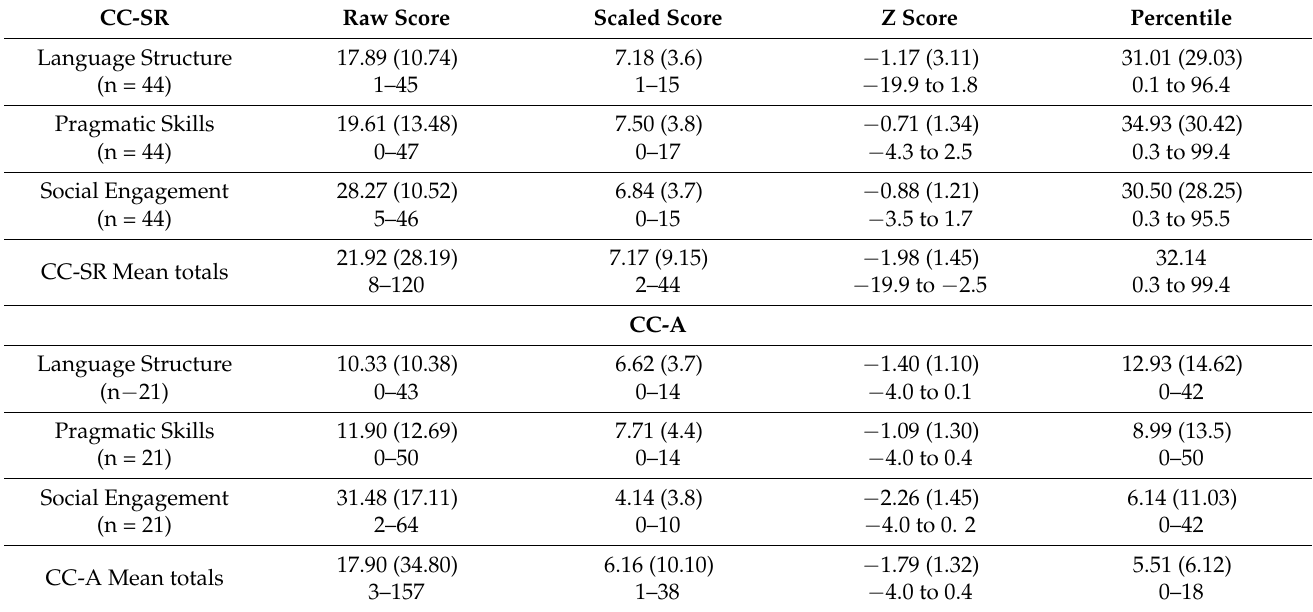
Table 3. Communication Checklist—Self Report (CC-SR) and Adult Report (CC-A) mean scores, standard deviations, ranges and